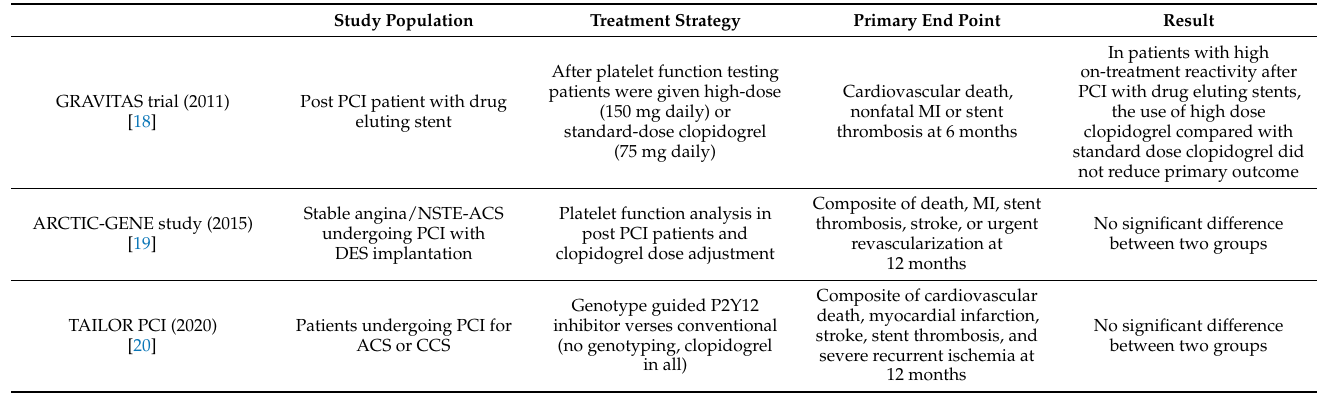
Table 2. Clinical evidence for tailoring DAPT based on platelet function